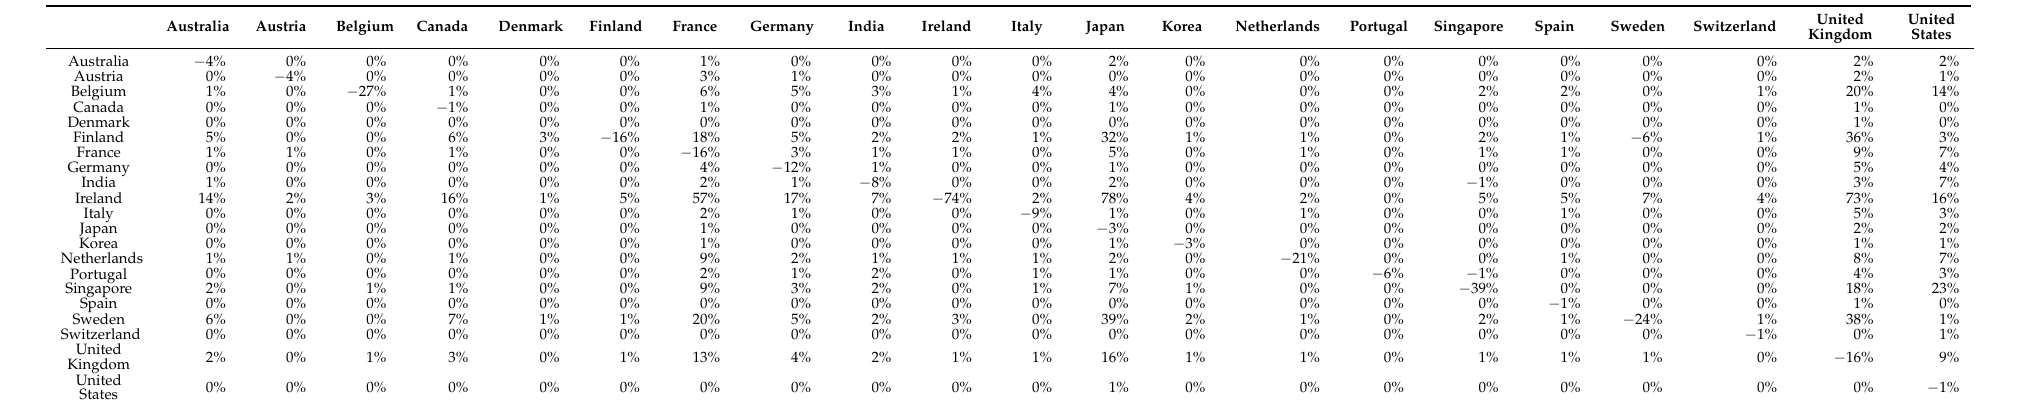
Table 5. Variation in countries’ systemic risk contributions when the column header country is not lending to other countries